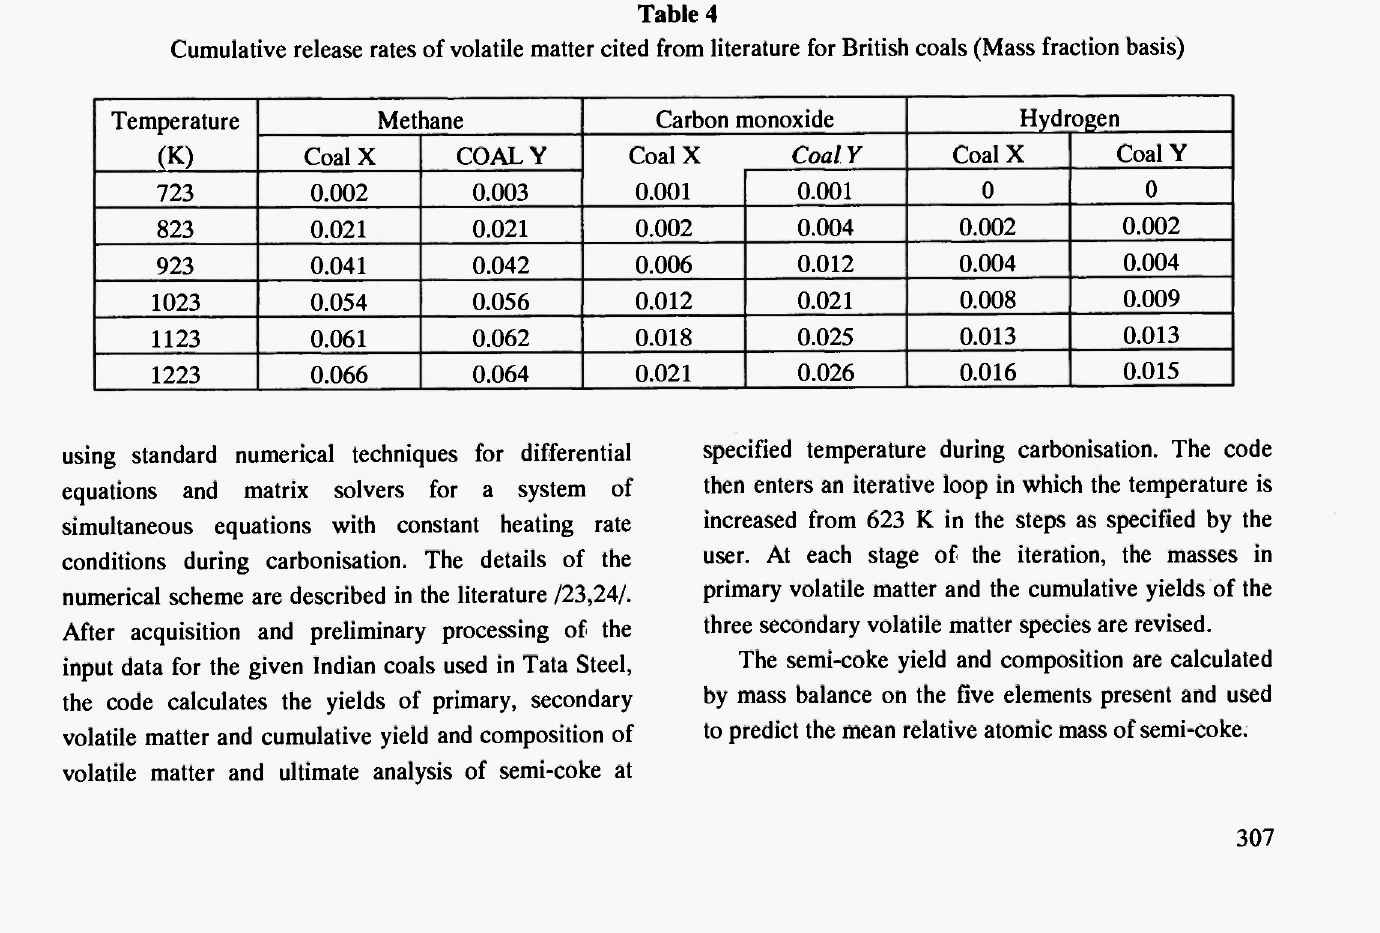
Experimental validation of computer predictions for coal